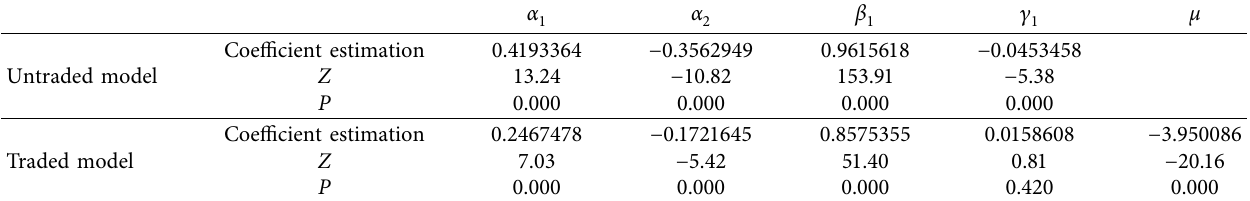
α α 1 2 α α 1 2